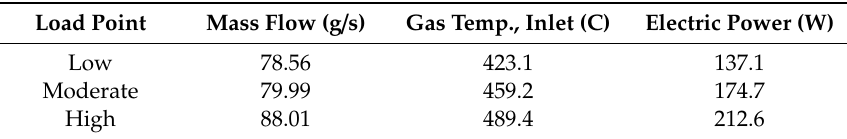
Table 1. Engine bench load points used for model